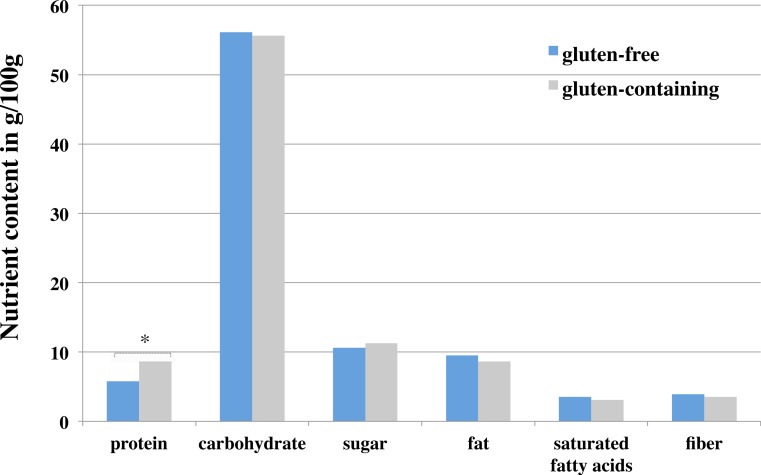
Nutrient content in g/100 g between gluten-free and gluten-containing foods across seven different food categories.Notes. Data displayed as mean values. * Significant differences (p < 0.05) between gluten-free and gluten containing foods.